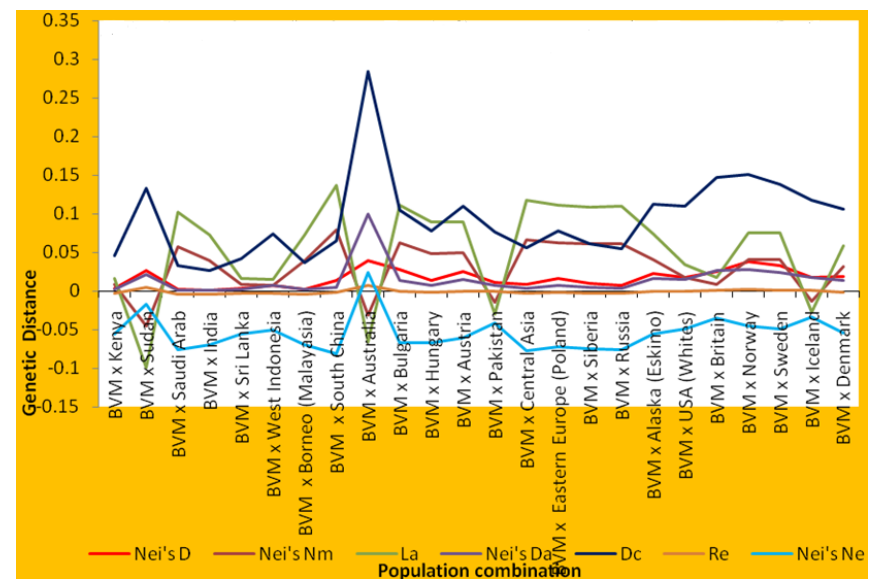
Fig. 2. Comparison of various genetic distance measures between BVM and other nations for ABO